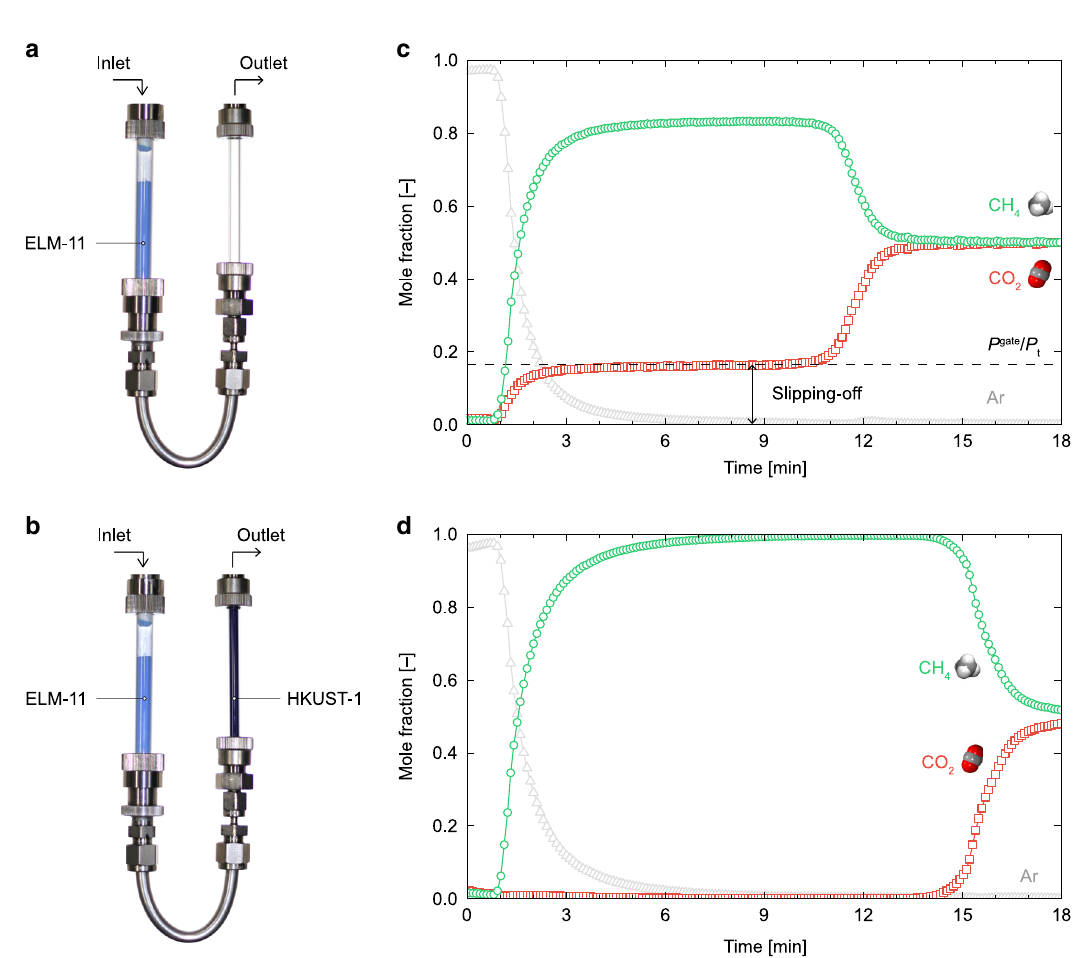
Fig. 6 Slipping-off problem and sequential-column system as a solution to this problem. Photographs of the column system used to measure the breakthrough curves: a a single-column system containing ELM-11 and b a sequential-column system containing ELM-11 and HKUST-1. c , d are breakthrough curves for an equimolar CO 2 /CH 4 gas mixture in a and b , respectively. The fl ow rate of the gas mixture was 20 sccm, and the adsorption columns were kept at 273 K. The outlet pressure was maintained at 200